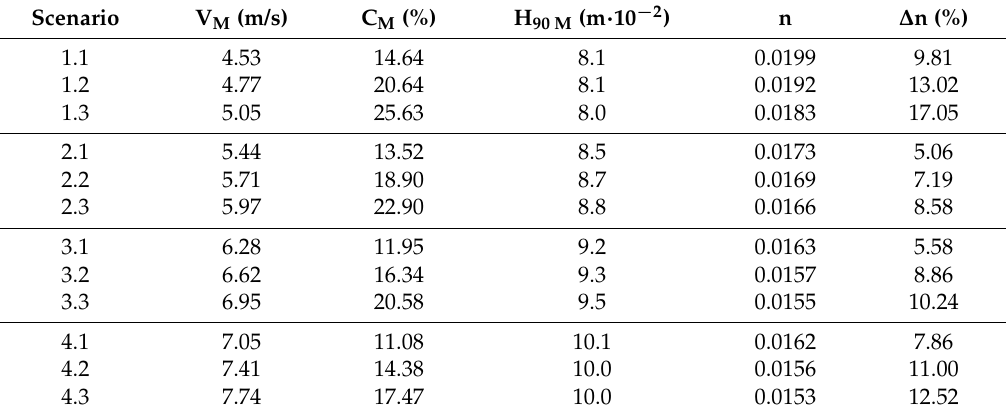
Table 3. Average velocity, concentration, H 90 and n value at the middle section of the